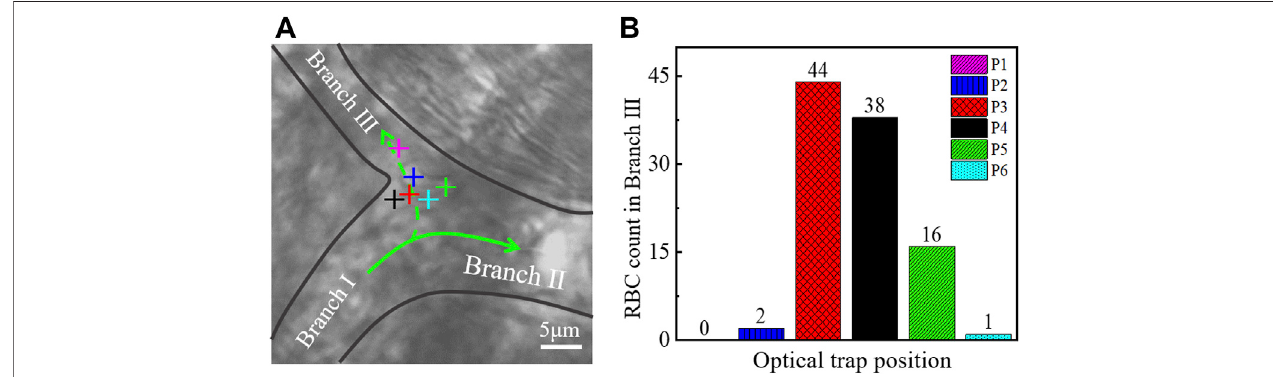
FIGURE4|(A) Opticaltrapwaslocatedindifferentpositionsinamicrovessel.Differentcolorsof ‘ + ’ representdifferentpositionsoftheopticaltrap. (B) Relationship betweenthepositionoftheopticaltrapandtheamountofredirectionRBCs.Thecolorofthehistogramcorrespondstothecoloroftheopticaltrapin (A) . ‘ + ’ indicatesthe optical